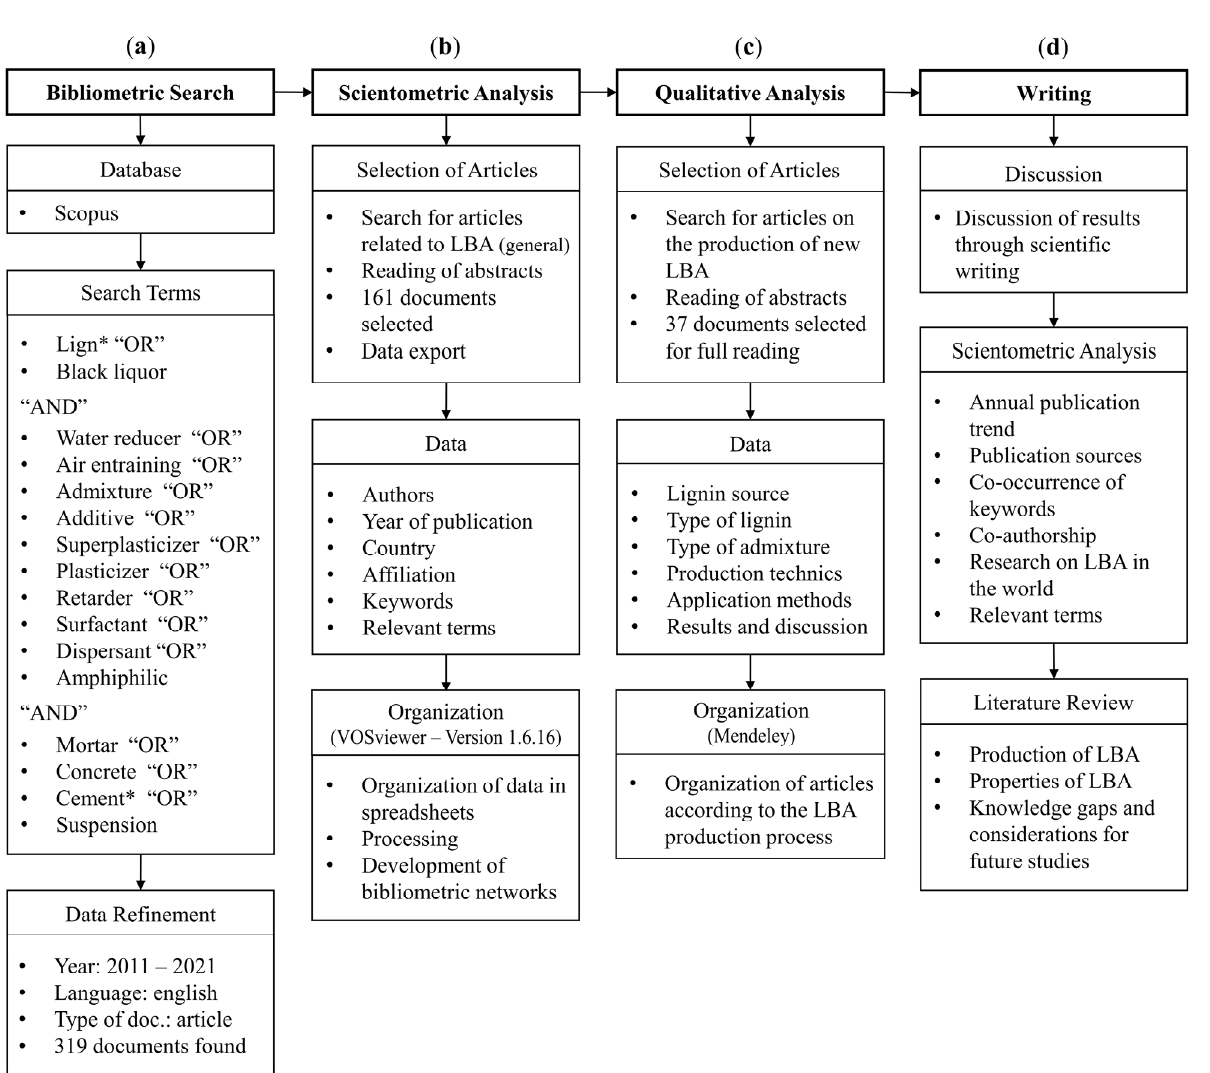
Figure 2. Stages of science mapping and literature review: ( a ) Bibliometric Search; ( b ) Scientometric Analysis; ( c ) Qualitative Analysis; ( d ) Writing. The asterisk symbol and the commands “AND” and “OR” were used in Scopus to expand and organize the bibliometric search, respectively.